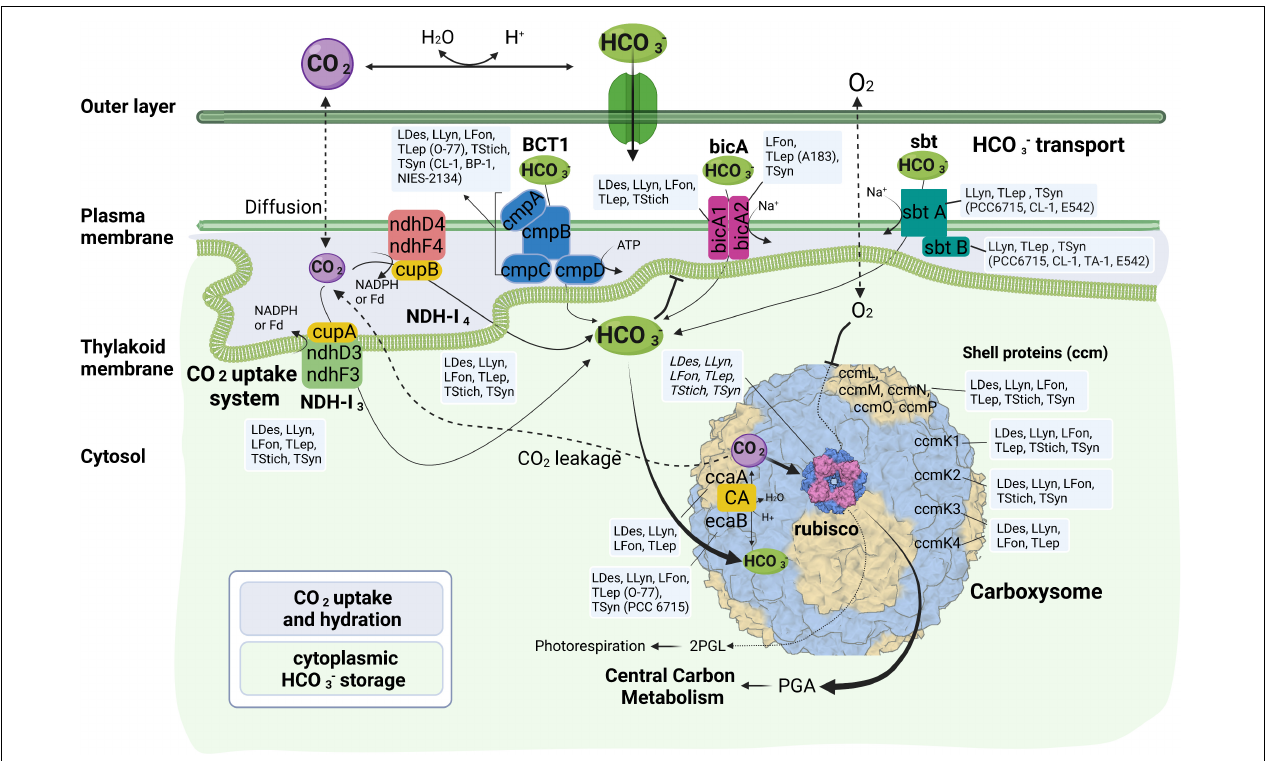
FIGURE 3 | Molecular components of CCM characteristic for various strains of thermophilic cyanobacteria divided according to their function. LDes – Leptodesmis , LLyn – Leptolyngbya , LFon – Leptothermofonsia , TLep – Thermoleptolyngbya , TStich – Thermostichus , TSyn – Thermosynechococcus ; 2PGL – 2-phosphoglycolate; PGA – phosphoglyceric acid. Figure created with